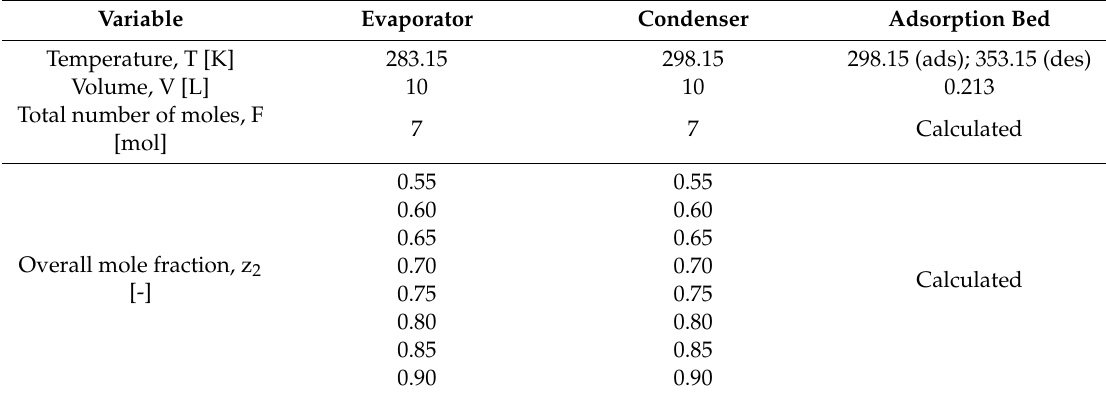
Table 2. Initial Conditions of the Refrigeration System Using the Binary System Ammonia (1) / Ethanol (2).